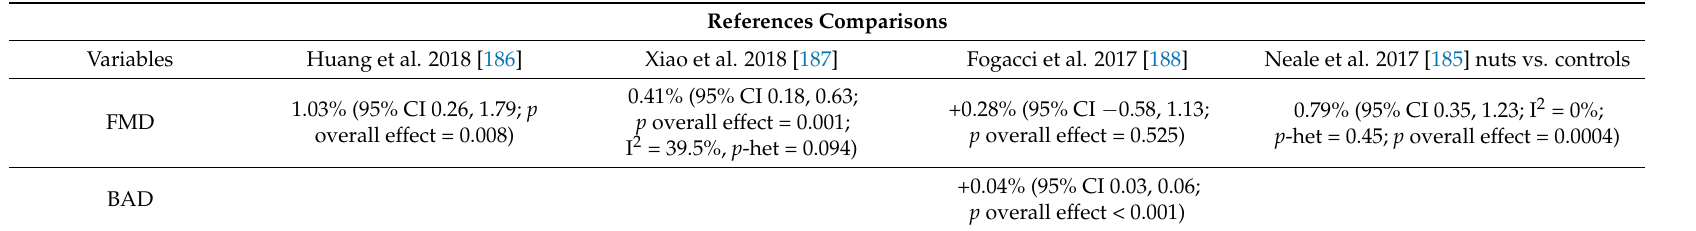
Table 6. Summary of nut consumption and endothelial function in intervention